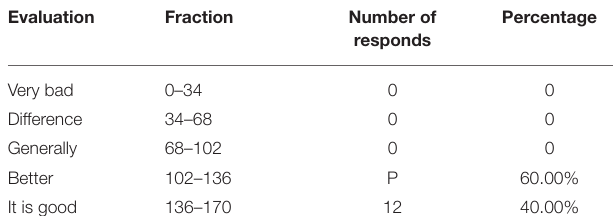
TABLE 3 | The distribution of the total score of the textbook incentive questionnaire.